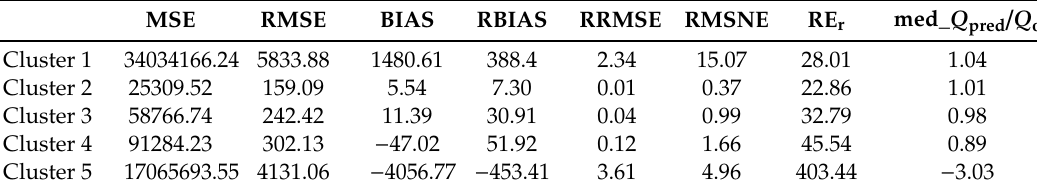
Table 12. Statistical evaluation for cluster 1 for 5% AEP flood (blue indicates best result).